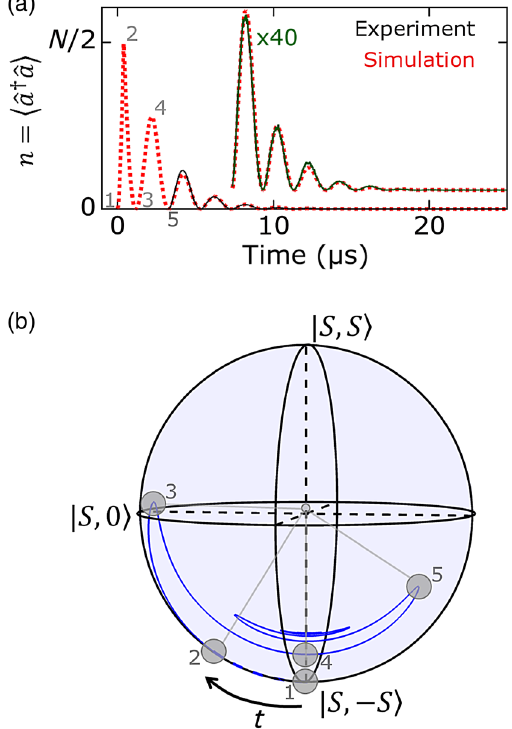
FIG. 4. Collective dynamics between the pseudospin and cavity. (a) Cavity photon number [ n ð t Þ ¼ h ˆ a † ˆ a i ] during the FID experiment [the square of the FID amplitude shown in Fig. 3(c)] with N ¼ 3 . 6 × 10 13 and M ≈ 0 . The simulated fit according to Eq. (3) is also shown (dashed curve). The tail of the decay is magnified 40 × and shown in green. (b) The pseudospin evolution on the Bloch sphere as determined from h h ˆ S ð t Þi in this simulation. The numbers (1 – 4) on the curves z indicate equivalent points in time during the FID on the micro- wave emission plot (a) and the simulated pseudospin evolution plot (b). The dynamics of the pseudospin in this large N limit is governed by the Maxwell-Bloch